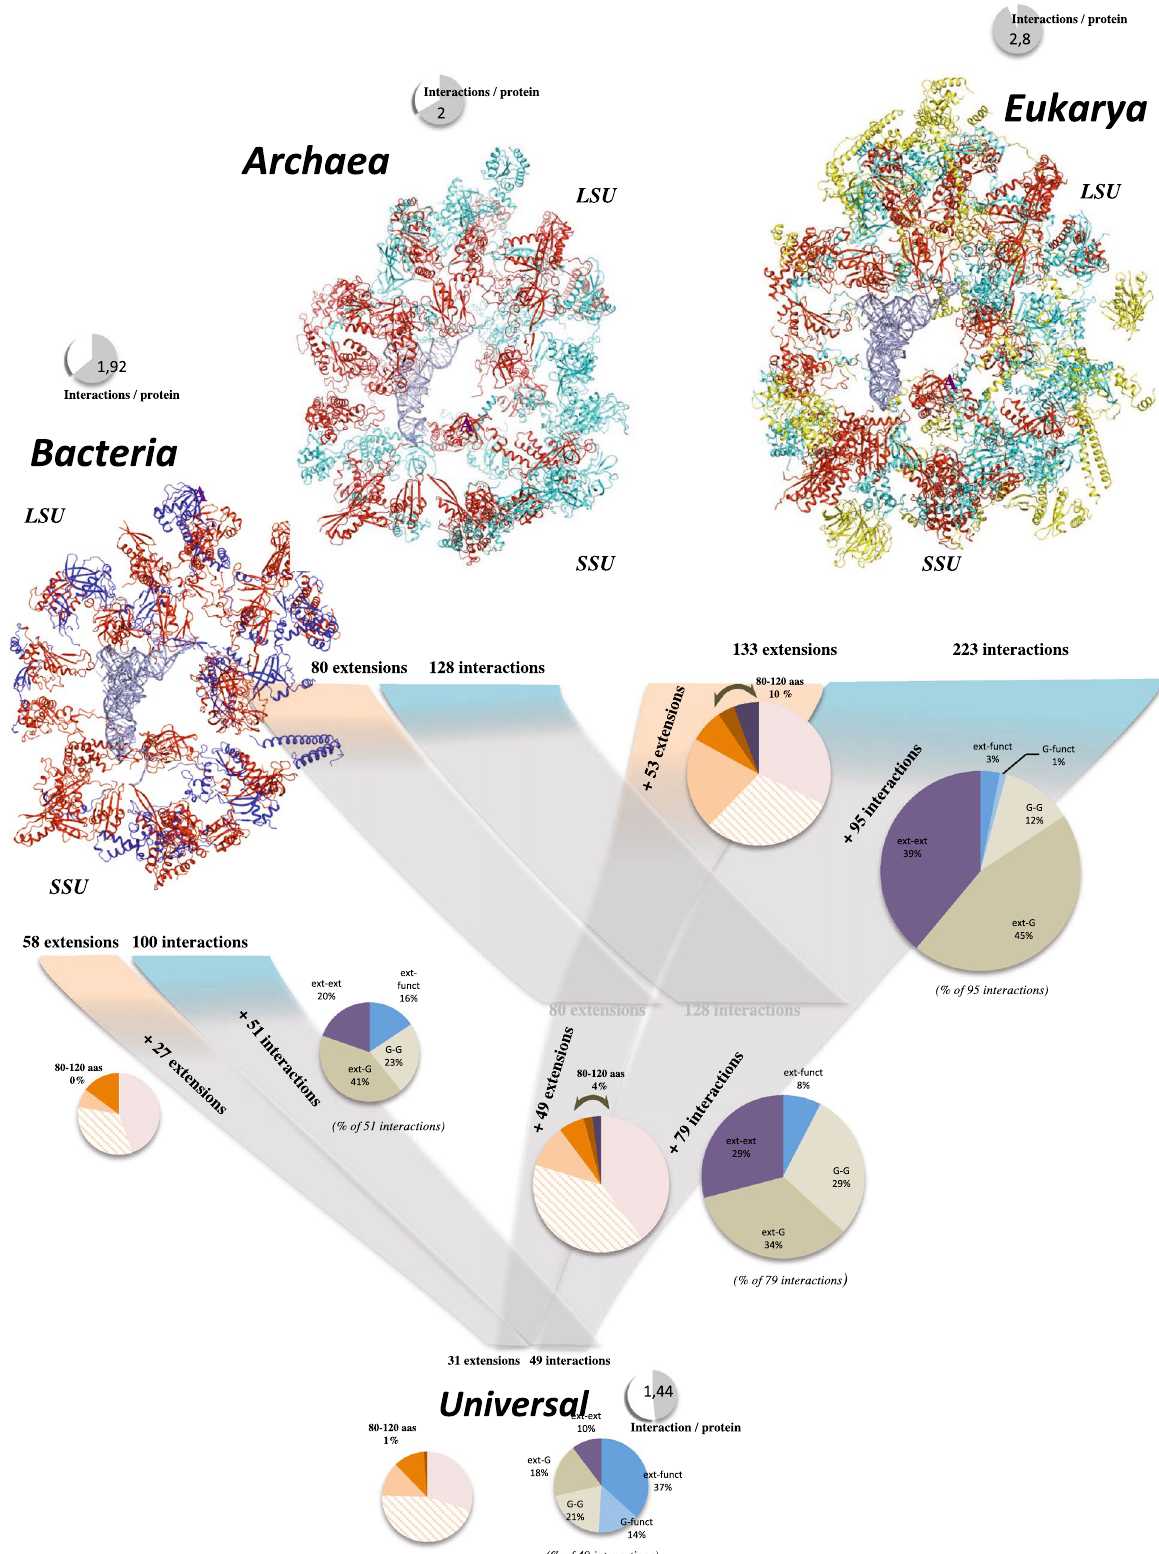
Figure 1. Evolution of the r-protein interactomes. In the three kingdoms’ networks, the r-protein components are represented according to their evolutionary status with the following colour code: red: universal; blue: bacteria; cyan: archaea; yellow: eukarya. Pie charts report the proportion of extension sizes and of contact types that have been acquired at each transition, respectively. Abbreviations: ext-ext: extension-extension; ext-G: extension-globular domain; ext-funct: extension-functional site; G-G: globular domain-globular domain; G-funct: globular domain-functional